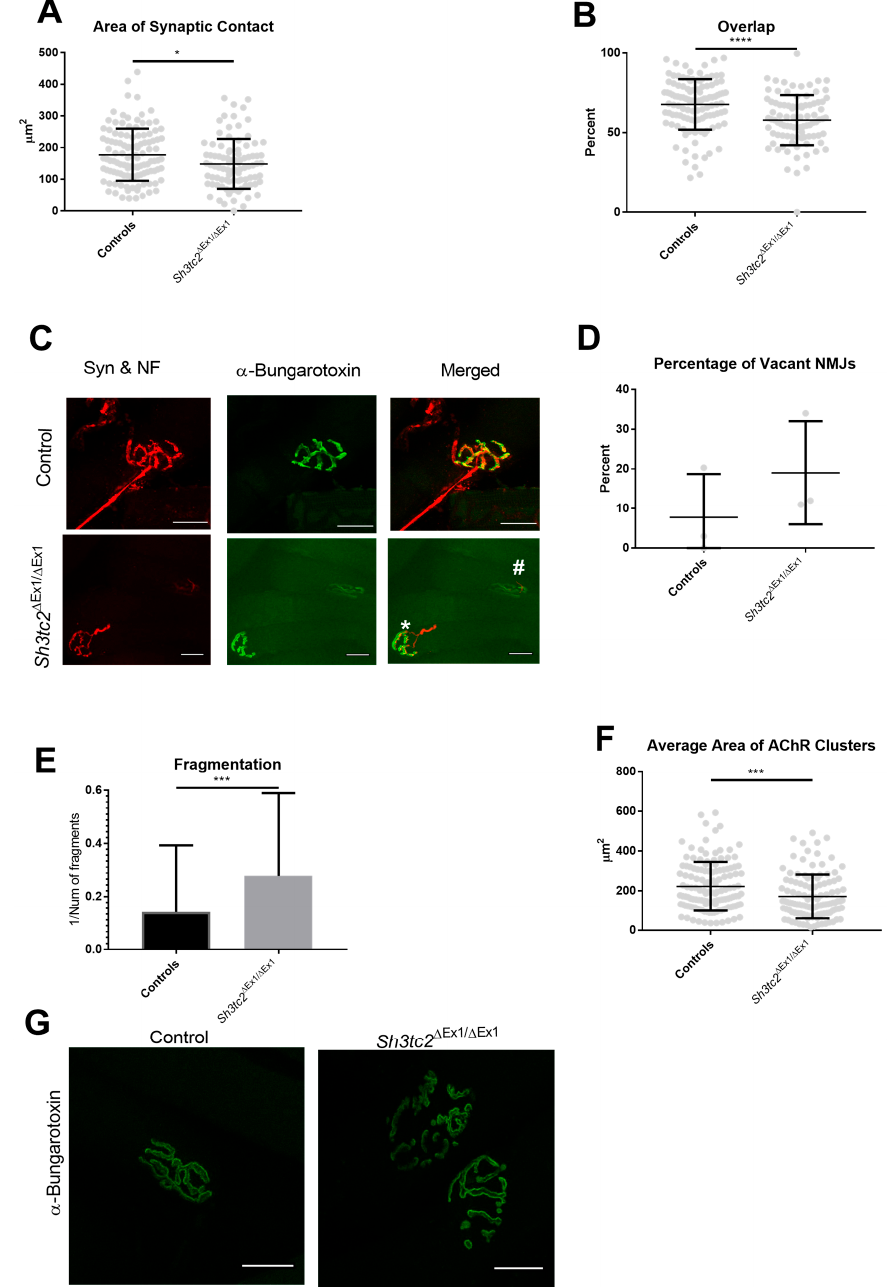
Figure 2. Changes in neuromuscular junction (NMJ) “alignment” and fragmentation at the endplate of Sh3tc2 Δ Ex1/ Δ Ex1 ( n = 3) mice compared to control ( n = 3) animals. ( A ) The area of synaptic contact between the pre- and post-synaptic apparatus is reduced in the NMJs of Sh3tc2 Δ Ex1/ Δ Ex1 mice (NMJs n = 91) when compared to control mice (NMJs n = 115) (Mann-Whitney test); ( B ) In addition, the percentage overlap, defined as the extent to which the nerve terminal overlaps the AChRs, was